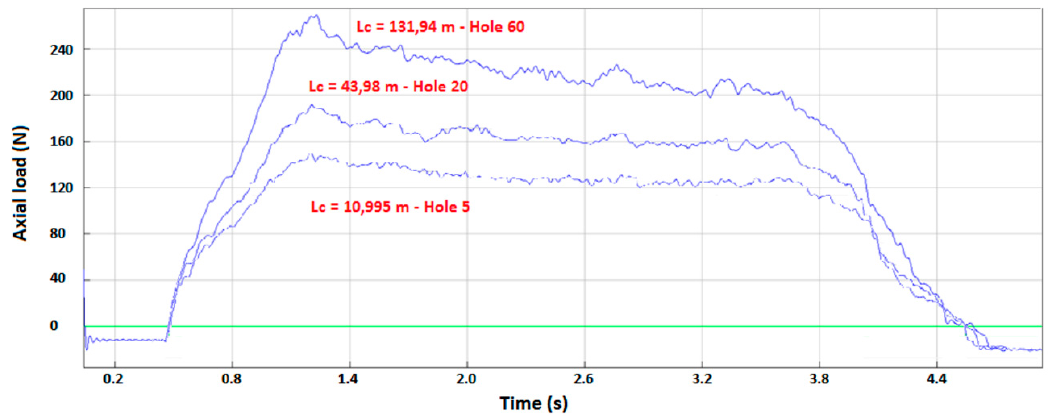
Figure 6. Thrust force versus time in carbon fiber composite materials (CFRP) plate alone.